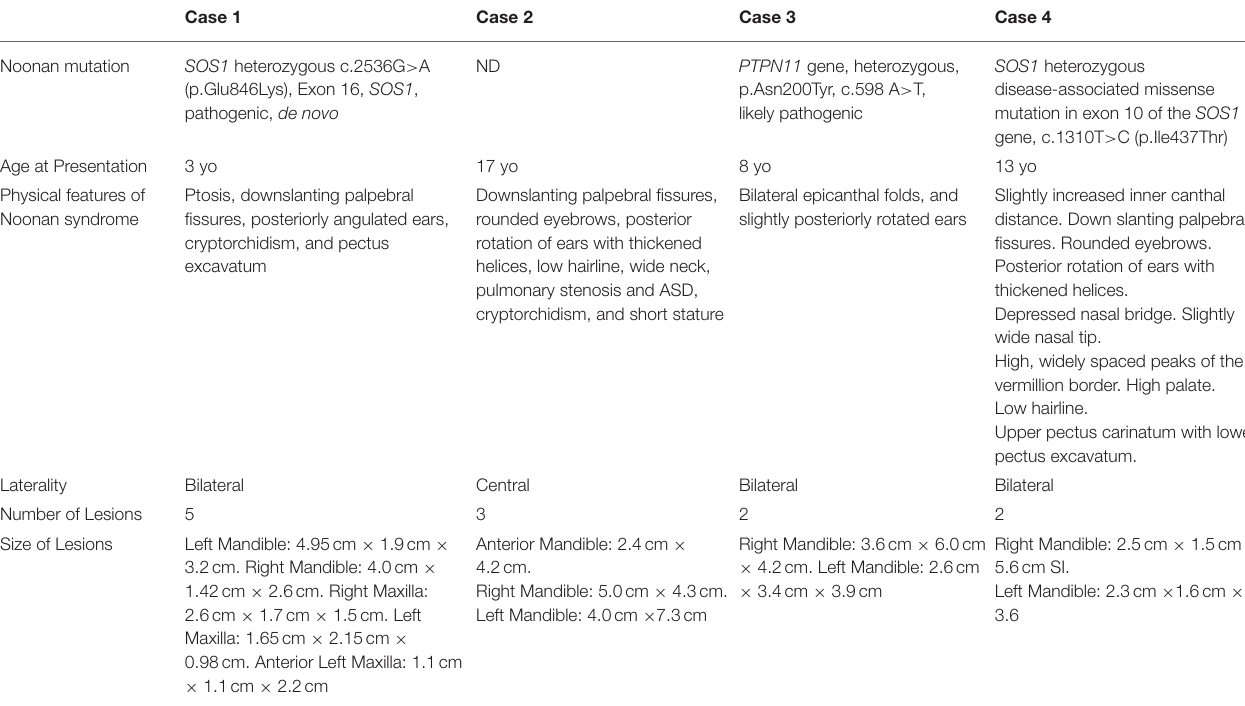
TABLE 1 | Basic patient